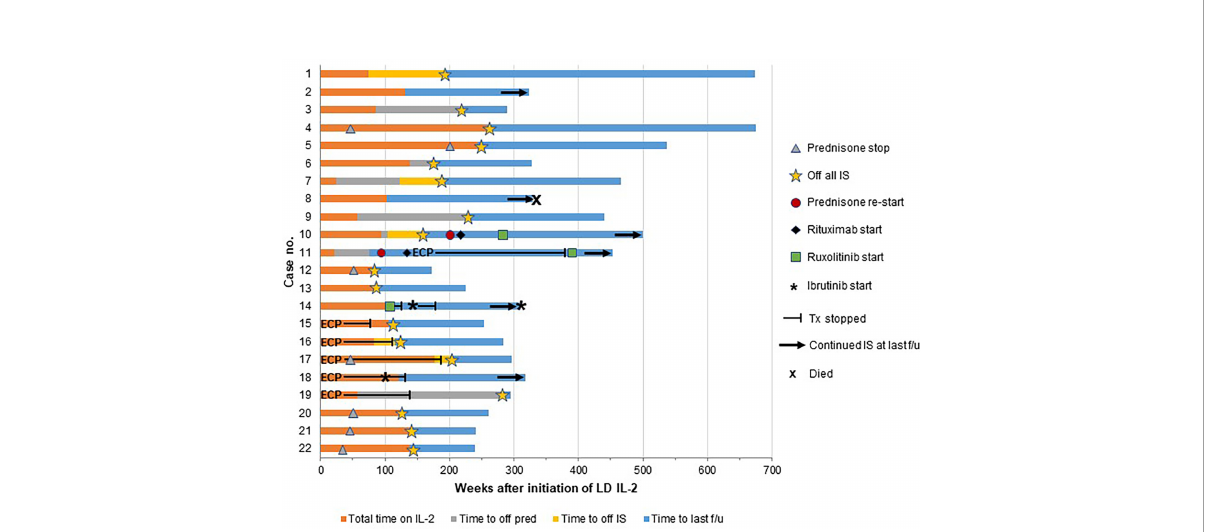
FIGURE 1 Clinical outcomes after IL-2 discontinuation. Each patient is represented by a horizontal bar with the time on low-dose IL-2 (LD IL-2) represented in orange and the time after IL-2 discontinuation represented in blue. The majority of the patients were able to discontinue all immunosuppression after stopping LD IL-2, but 3 patients (case numbers 10, 11, and 14) had progression of chronic GVHD requiring initiation of additional immunosuppression and 3 patients (case numbers 2, 8, and 18) continued on their prior immunosuppressive agents at the time of last follow up. Time to discontinuation of prednisone is represented as gray bars if prednisone was stopped after IL-2 discontinuation. If prednisone was weaned off during the IL-2 treatment course, the time of discontinuation is represented by a gray triangle. The time to discontinuation of all immunosuppression (IS) is represented as yellow bars and yellow stars. ECP, extracorporeal photopheresis; f/u, follow up; no., number; pred, prednisone; Tx,